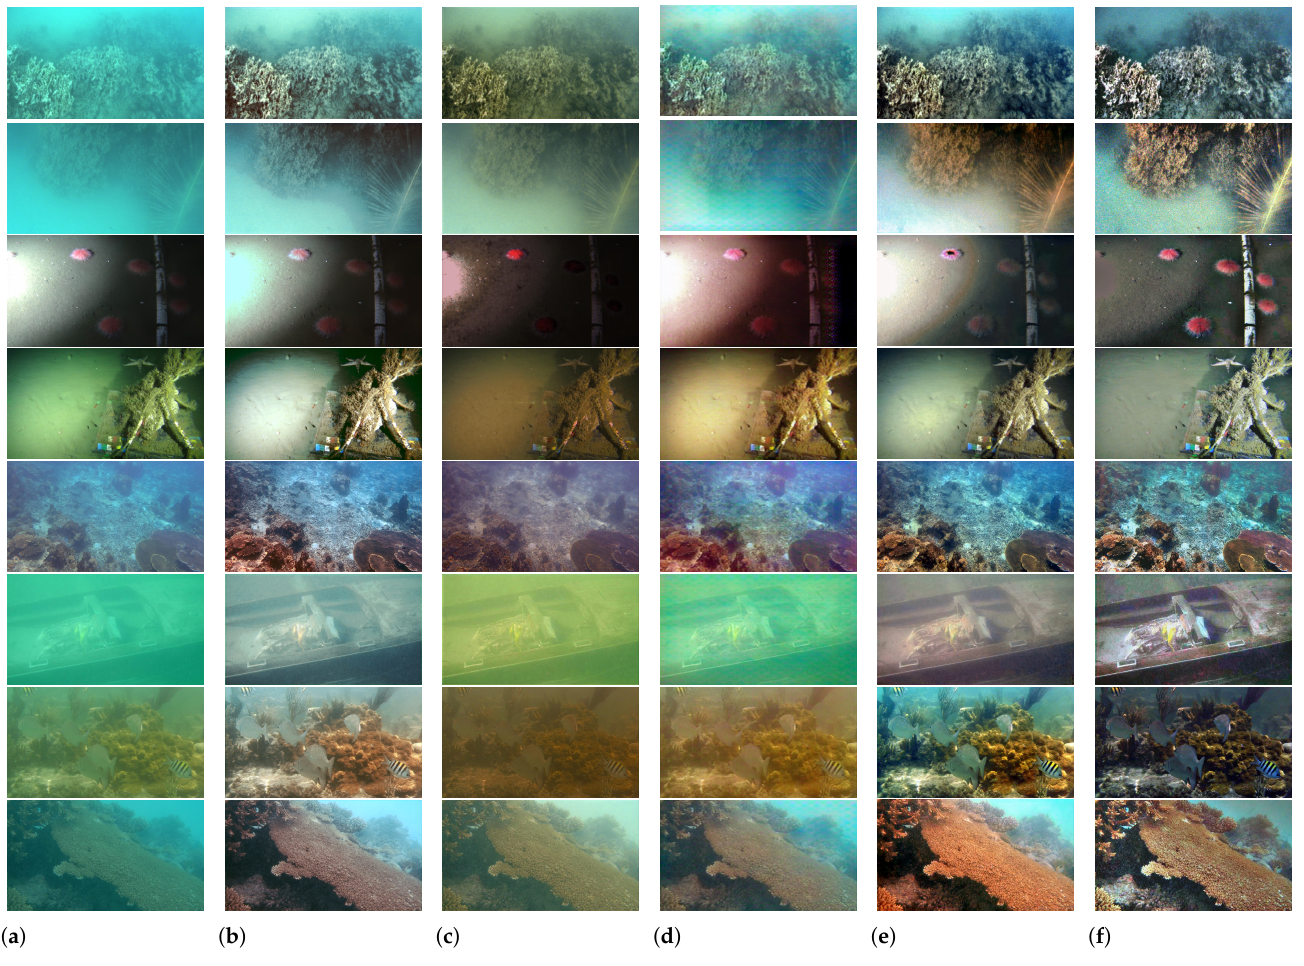
Figure 11. Images for qualitative comparison between our method and others, including a method based on deep learning and image formation model by Chen et al., UWCNN, FUnIE-GAN and TACL. ( a ) Input image. ( b ) Chen et al. [27]. ( c ) UWCNN [28]. ( d ) FUnIE-GAN [29]. ( e ) TACL [17]. ( f )